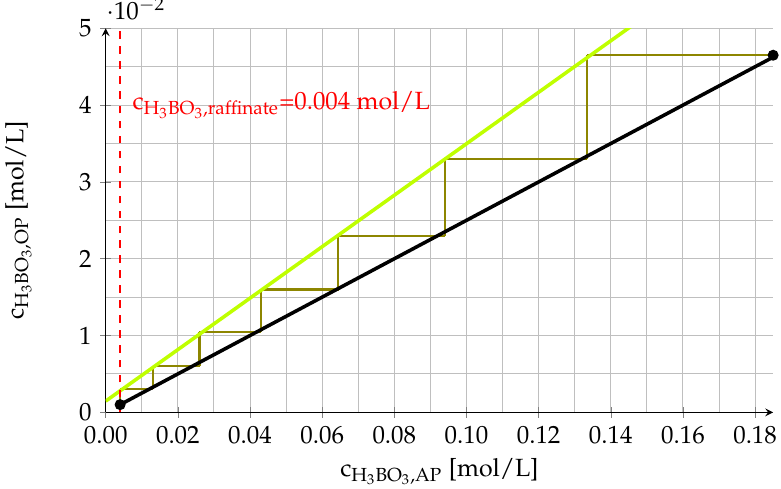
Figure 12. McCabe–Thiele diagram for case 1 at a phase ratio of